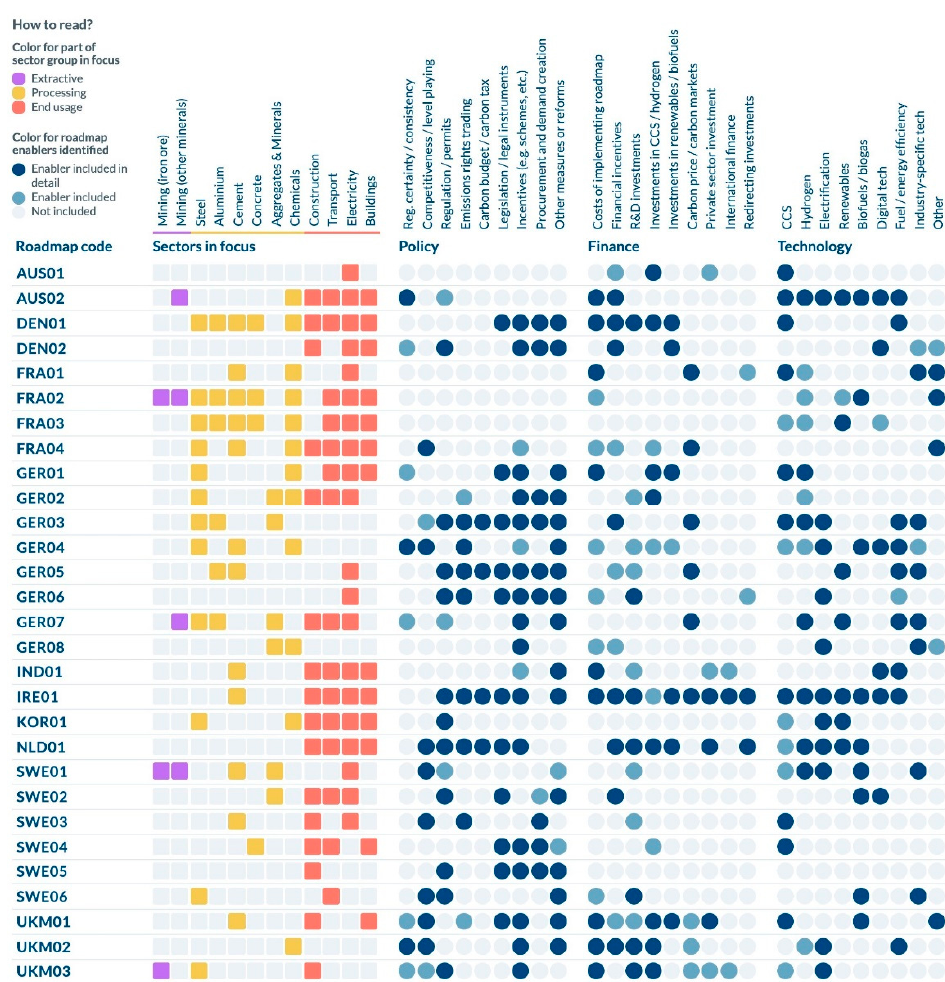
Figure 4. Comparison of roadmaps requirements across all roadmaps (source: author’s own).